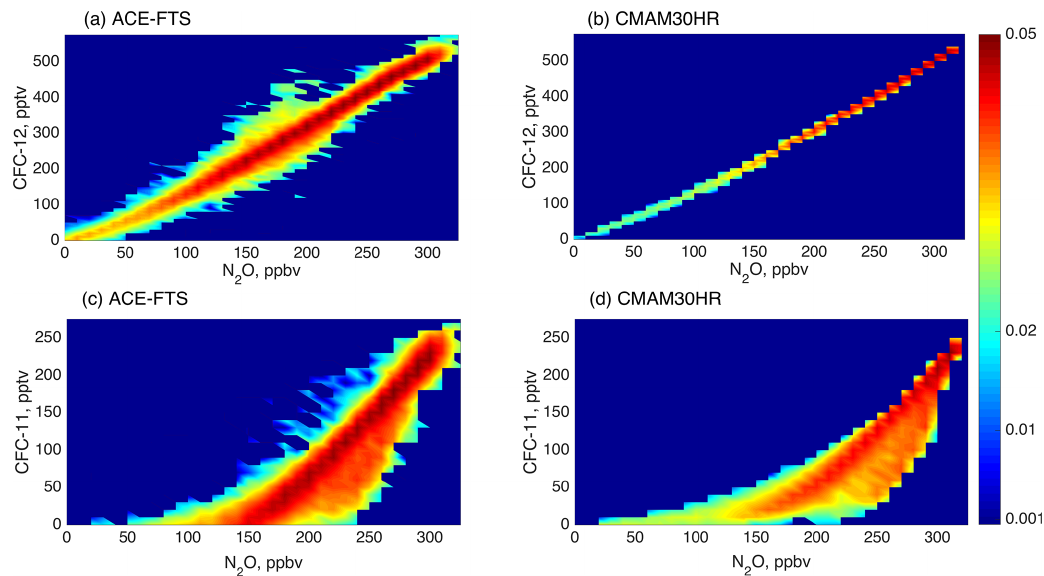
Figure 13. JPDFs, as described in the text, of N 2 O–CFC-12 for (a) ACE-FTS and (b) CMAM30HR, and N 2 O–CFC-11 for (c) ACE-FTS and (d) CMAM30HR. All stratospheric ACE-FTS observations and subsampled model output in the Northern Hemisphere are